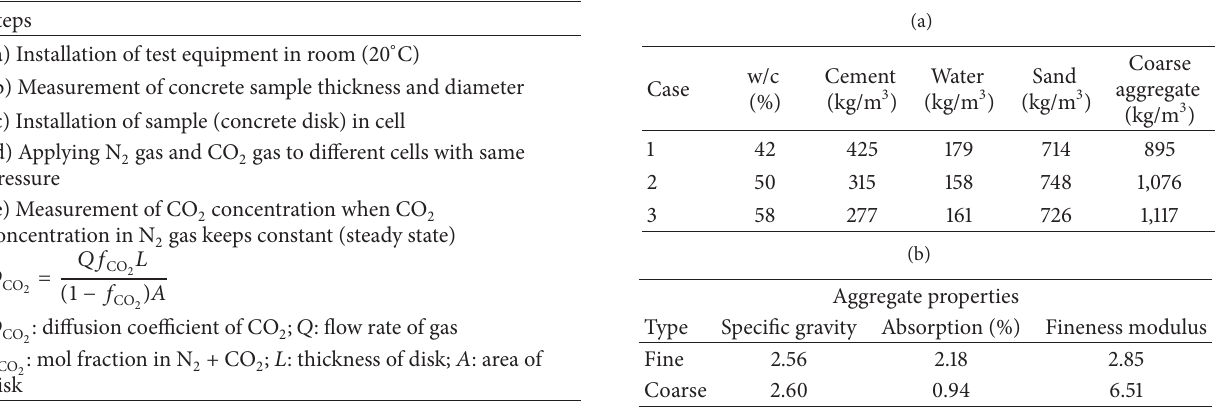
Table 3: Summary of test setup [14]. Table 4: Mix proportions for CO